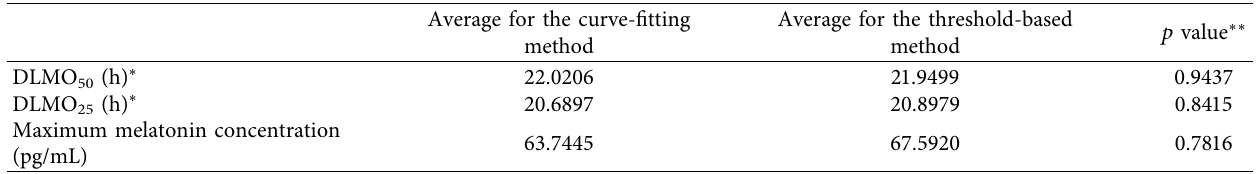
Table 2: Comparison of the curve-fitting and threshold-based (with a linear interpolation) methods—the DLMO50, DLMO25, and maximum and minimum melatonin